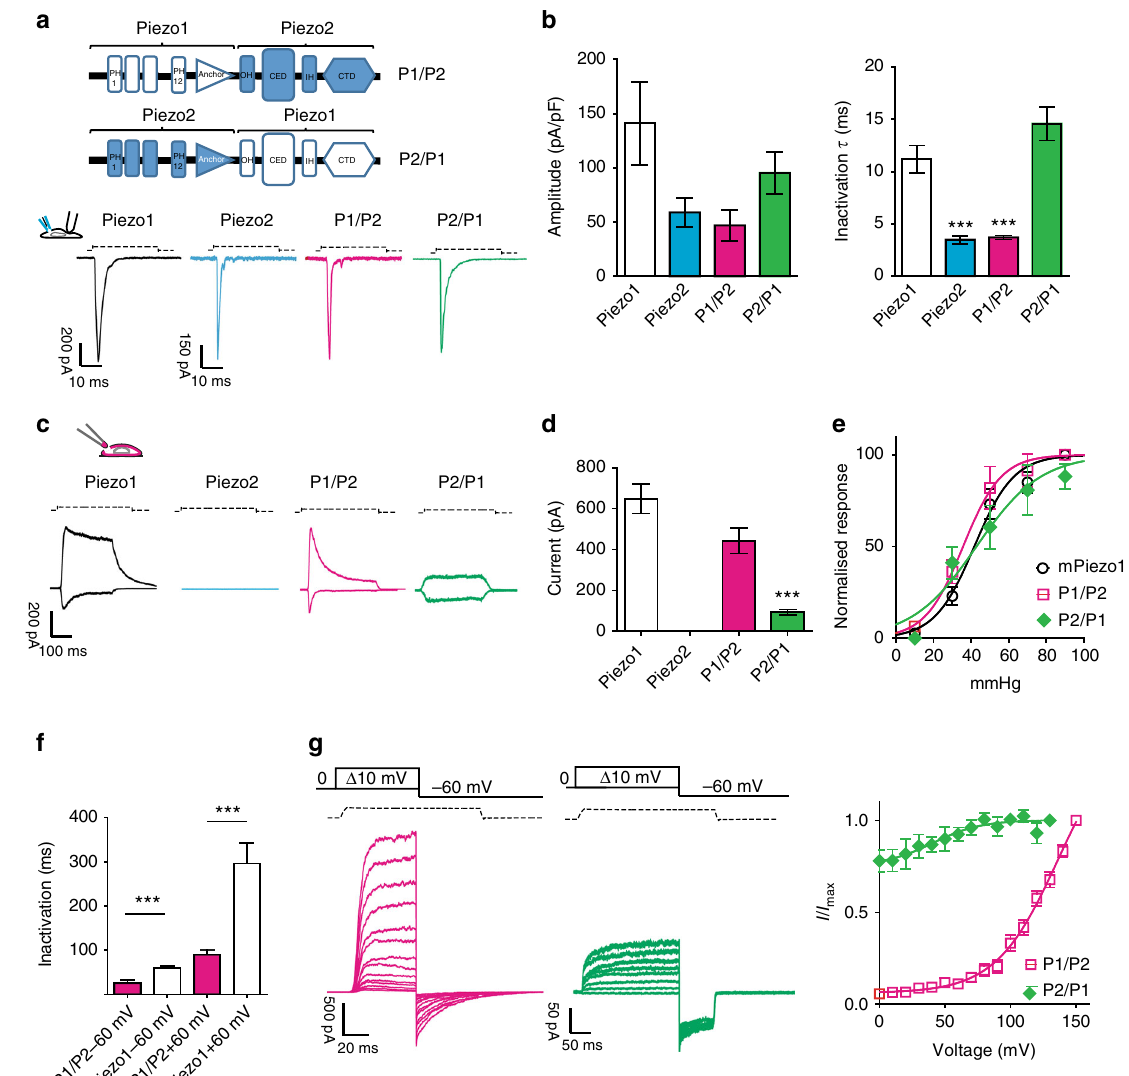
Fig. 5 PIEZO chimeras respond to membrane stretch. a Chimeric PIEZO channels were constructed by fusing the N-terminal region of one protein to the pore domain of the other protein including the CED region. PIEZO1, PIEZO2, and the chimeric channels were overexpressed in N2a Piezo1 − / − cells (Supplementary Fig. 3). Cells were clamped at − 60 mV and subjected to soma indentation. b The maximum current amplitude (normalized for the capacitance) is plotted. The time course of inactivation for each construct was fi tted to a mono-exponential function. PIEZO1 inactivation was approximately threefold slower than PIEZO2 and the chimeric receptor was P1/P2 (ANOVA, d F = 25, Dunnett ’ s post-hoc test P < 0.023). The P1/P2 chimera showed a current amplitude and a time course of inactivation similar to PIEZO2. The P2/P1 chimera showed a current amplitude and a time course of inactivation similar to PIEZO1. c Typical response of the chimeric channels and wild-type PIEZO1 to membrane stretch in outside-out patches. Outside- out patches pulled from cells overexpressing PIEZO2 did not respond to stretch stimulation. d Maximal current level recorded in outside-out patches at − 60 mV. Current levels for P2/P1 were signi fi cantly different from PIEZO1 patches ( n = 10, Student ’ s t- test, P = 0.0003, d F = 25. e Pressure – response relationships of the chimeric channels are not different from PIEZO1 (P1/P2 37.6 ± 4.6 mmHg, 10 cells; PIEZO1 38.9 ± 3.1 mmHg, 21 cells; P2/P1 42.4 ± 4.7 mmHg, 7 cells, Anova Dunnet ’ s post-test P = 0.78, d F = 32). f The decay of inactivation for pressure-mediated responses at + 60 and − 60 mV is